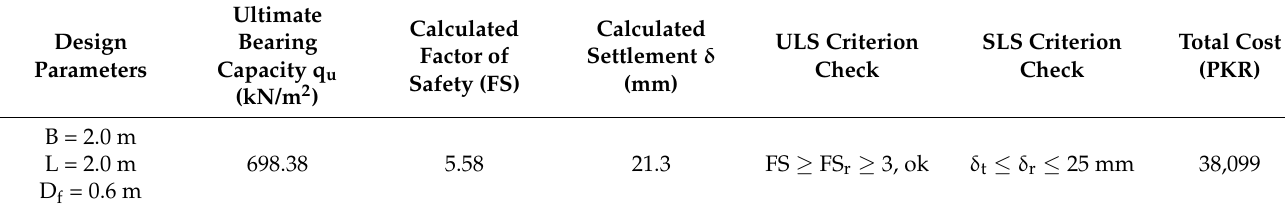
Table 2. Results of conventional design example.